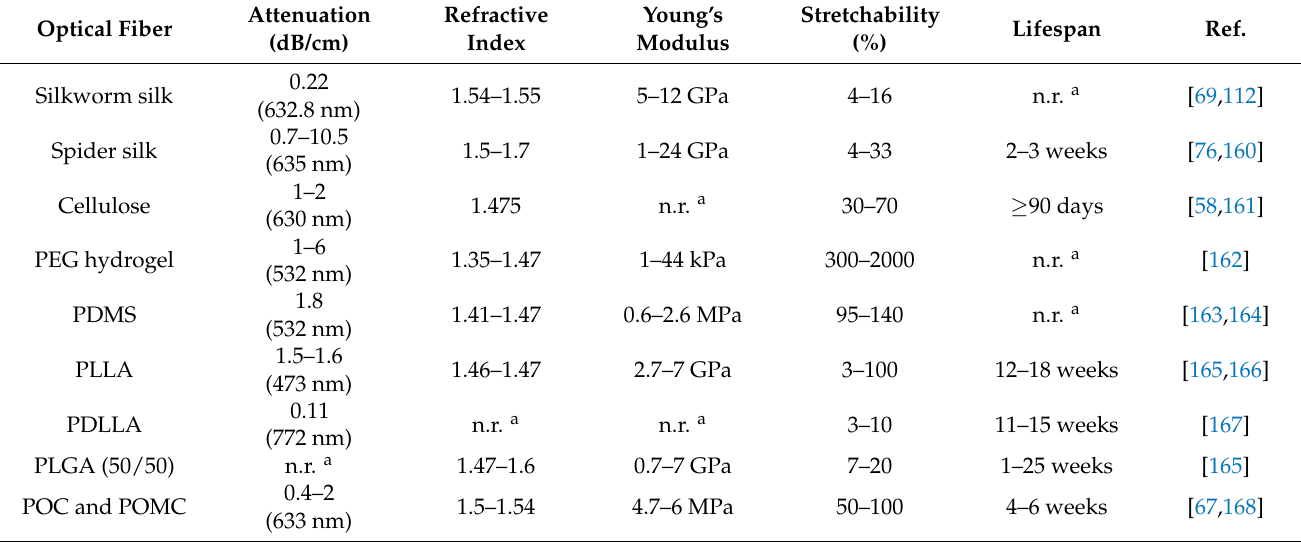
Table 8. Several typical polymeric biocompatible optical fibers and their